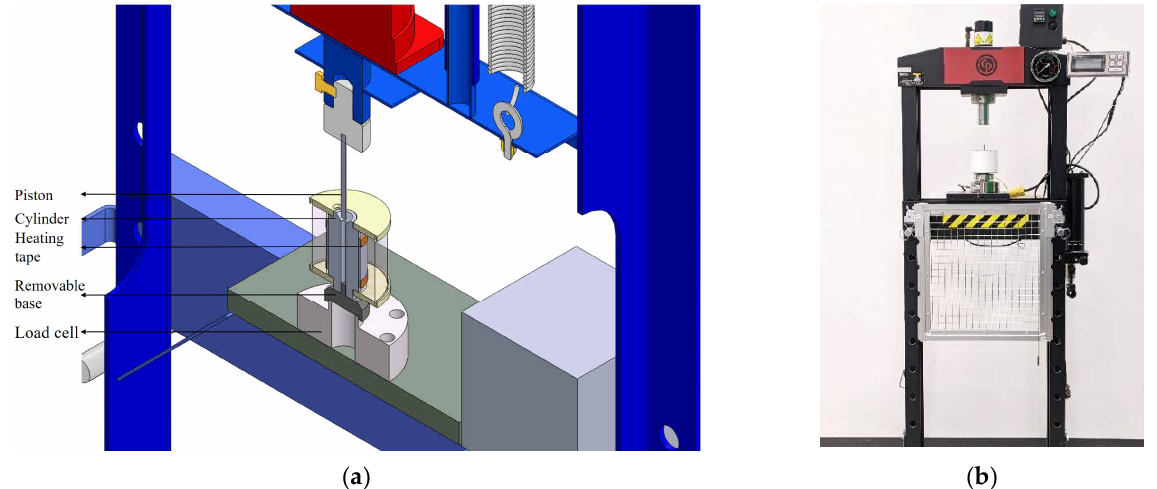
Figure 2. ( a ) 3D drawing of the experimental system designed to produce individual pellets and ( b ) picture of the actual experimental bench located at the Biomass Technology Laboratory in Sherbrooke, Québec, Canada.